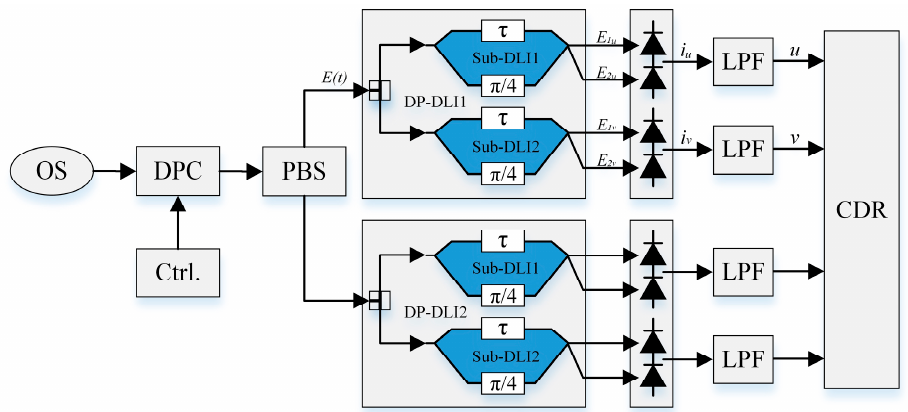
Figure 2. A schematic diagram of the structure of a delay-line interferometer (DLI)-based DP-QPSK receiver. OS: optical signal; DPC: dynamic polarization alignment controller; PBS: polarization beam splitter; LPF: low-pass filter; CDR: clock data recovery.